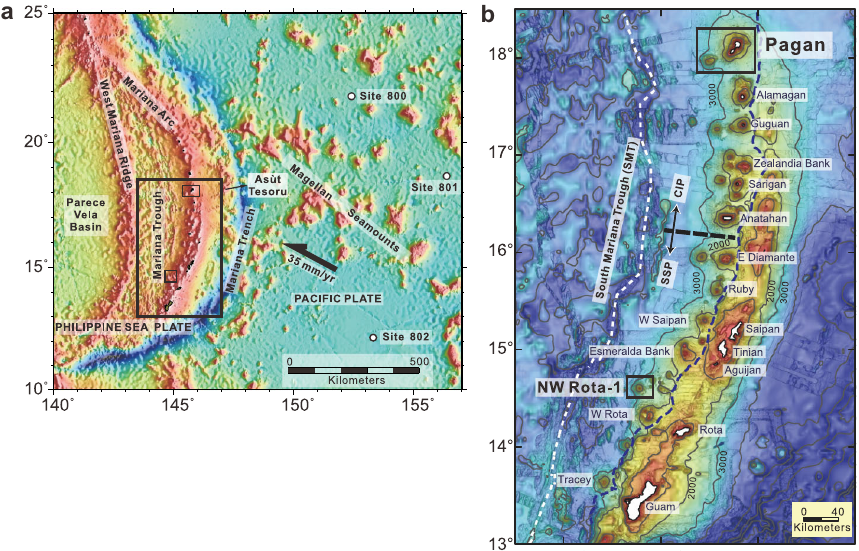
Fig. 1 Regional map of the Mariana convergent plate margin with sampling locations. a Regional map of the Mariana subduction system: the subducting Paci fi c Plate, Mariana Trench, Mariana Arc, Mariana Trough, West Mariana Ridge, and Parece Vela Basin. The Asùt Tesoru (Big Blue Seamount) mud volcano is located about 72 km west of the trench axis and 134 km east of the Pagan volcano and lies about 18 km above the downgoing Paci fi c plate 13 . Open circles denote Ocean Drilling Program drill Sites 800, 801, and 802. The rectangle shows the area enlarged in ( b ). b Map showing the southern Mariana arc, which includes from west to east the Mariana Trough (back-arc basin), the active Mariana arc, the old Mariana forearc (including the islands of Saipan, Tinian, Aguijan, Rota, and Guam), and the Mariana Trench. The white dashed line de fi nes the Mariana Trough spreading ridge. The blue dashed line shows the boundary between the active Mariana arc to the west and the uplifted Mariana frontal arc, part of the Mariana forearc. The maps are from Tamura et al. 7 . SSP Southern Seamount Province, CIP Central Island